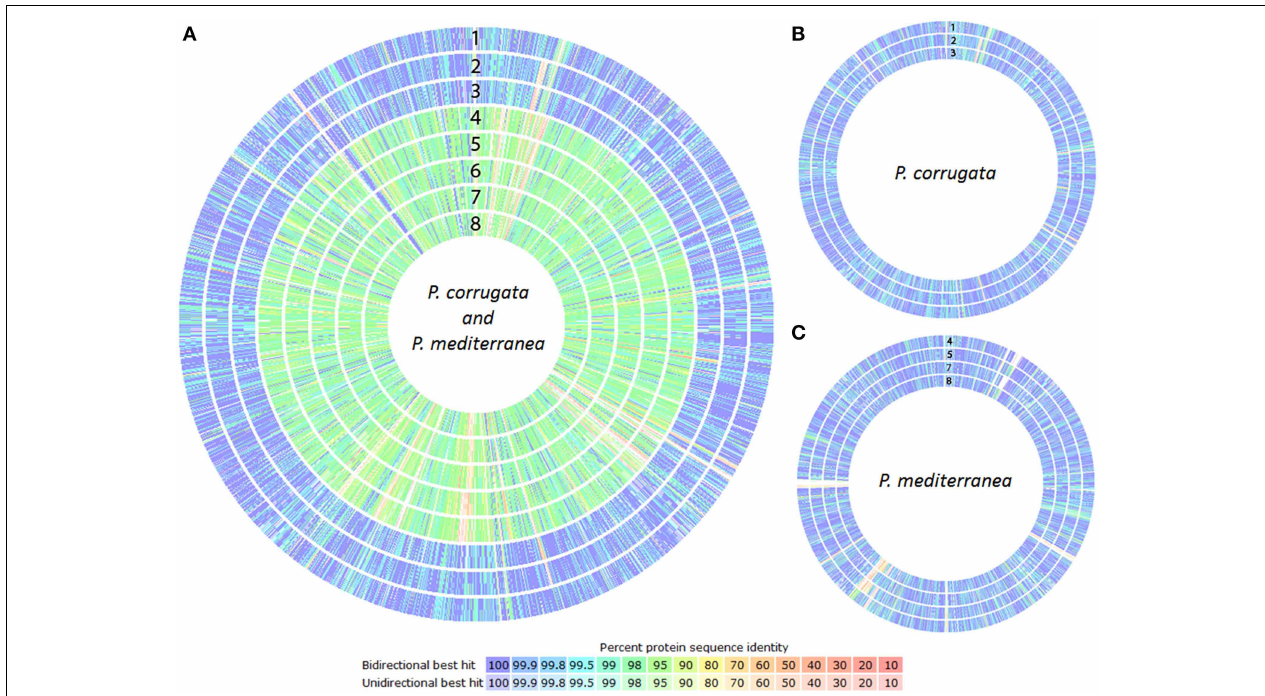
FIGURE 4 | Proteome comparison of the Pseudomonas corrugata ( Pcor ) and P. mediterranea ( Pmed ) strains based on RAST genome annotation. Each proteome is presented as a closed circle with similarity for each protein against the reference genome designated by colored lines. (A) Pcor and Pmed interspecific proteome comparison against Pcor NCPPB2445 type strain, (B) Pcor intraspecific proteome comparison